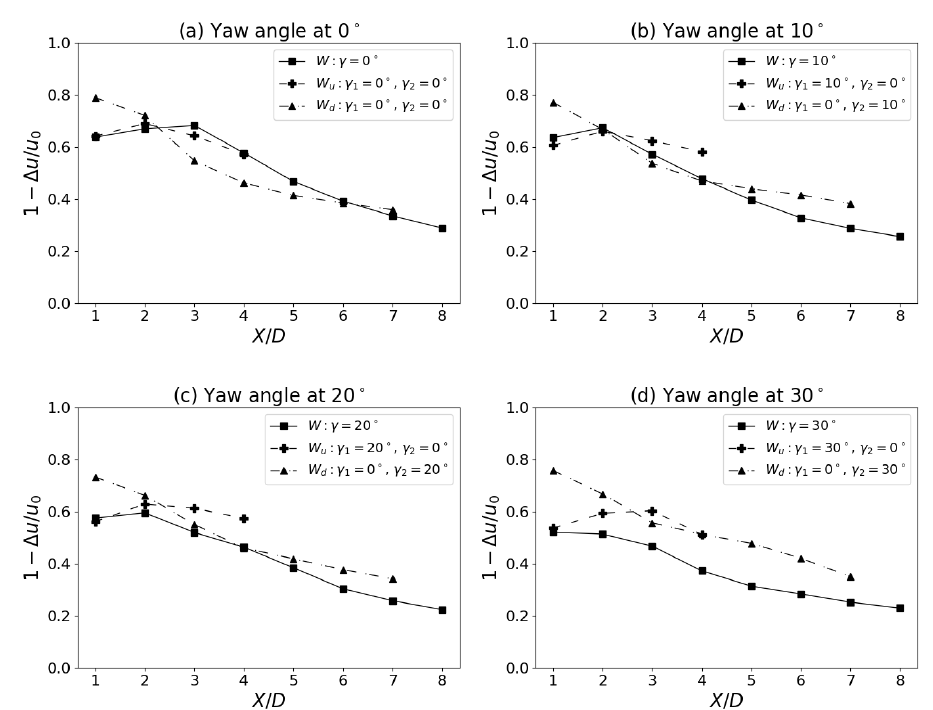
Figure 13. The velocity deficit along the wake centerlines under four different yaw angles. W : velocity deficit at wake centerlines in Scenario 1; W u : velocity deficit at upstream wake centerlines in Scenario 2; W d : velocity deficit at downstream wake centerlines in Scenario 2. In all cases, the quoted distances for W and W u are downstream of the upstream turbine, while the quoted distances for W d are downstream of the downstream